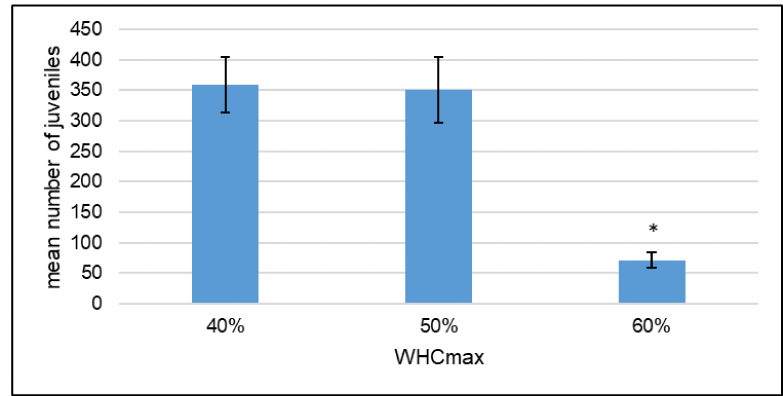
Figure 5. F. candida reproduction in the control treatments with different water contents. The mean number of juveniles after a 28 day reproduction test. The three treatments differ in percent of the maximum water holding capacity (WHCmax) of OECD soil. Mean ± SE, n = 8.